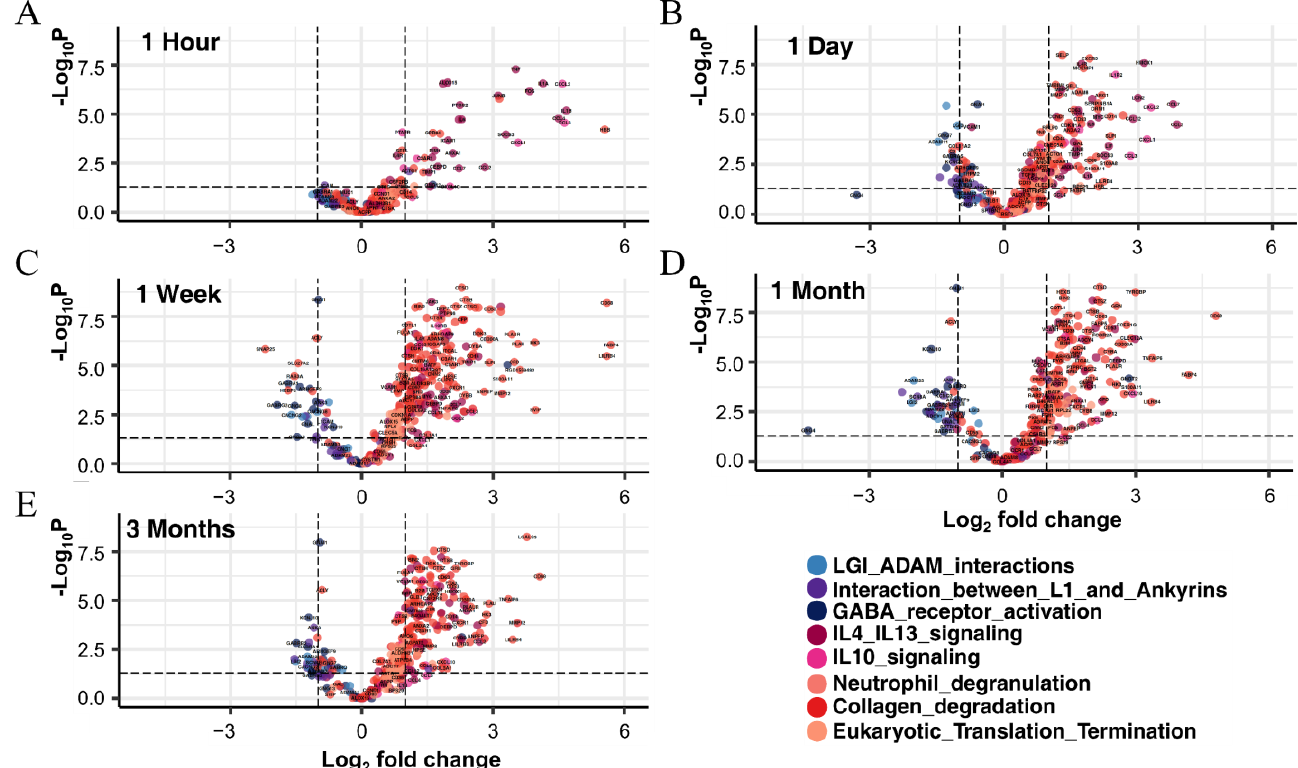
Figure 7. Volcano plots for gene expression according after SCI at five time points (1 hour ( A ), 1 day ( B ), 1 week ( C ), 1 month ( D ), and 3 months ( E ). Blue and red circles represent pathways to which down- and upregulated DEGs belong. The detailed patterns of each pathway are shown in Supplemental Figure S5.